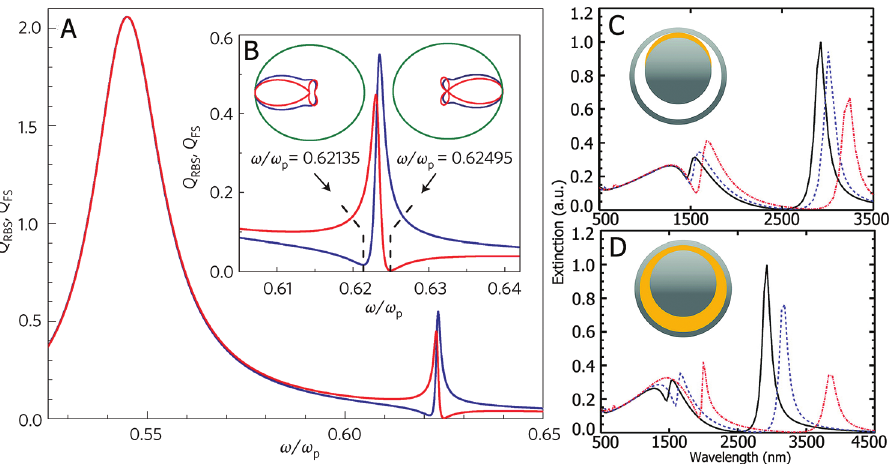
Figure 10 (A) and (B) Fano resonance in the differential scattering spectra of a plasmonic nanoparticle. (A) Spectra of radar backscatter- ing (RBS) and forward scattering (FS) that exhibit Fano-like asymmetric line shape. The angular dependence of scattering patterns at two frequencies in the vicinity of the quadrupolar resonance changes dramatically, with orientation from backward (red) to forward (blue). In the scattering diagram insets of (B), the closed curves in red and blue represent linearly polarized and nonpolarized incidence, respectively. (C) and (D) Fano resonances in nonconcentric ring/disk cavities with (C) partial and (D) complete filling of dielectrics with permittivity 1 (black solid), 1.5 (blue dashed), and 3 (red dotted). (A) and (B) are adopted from Ref. [184], and (C) and (D) are adopted from Ref. [191] with